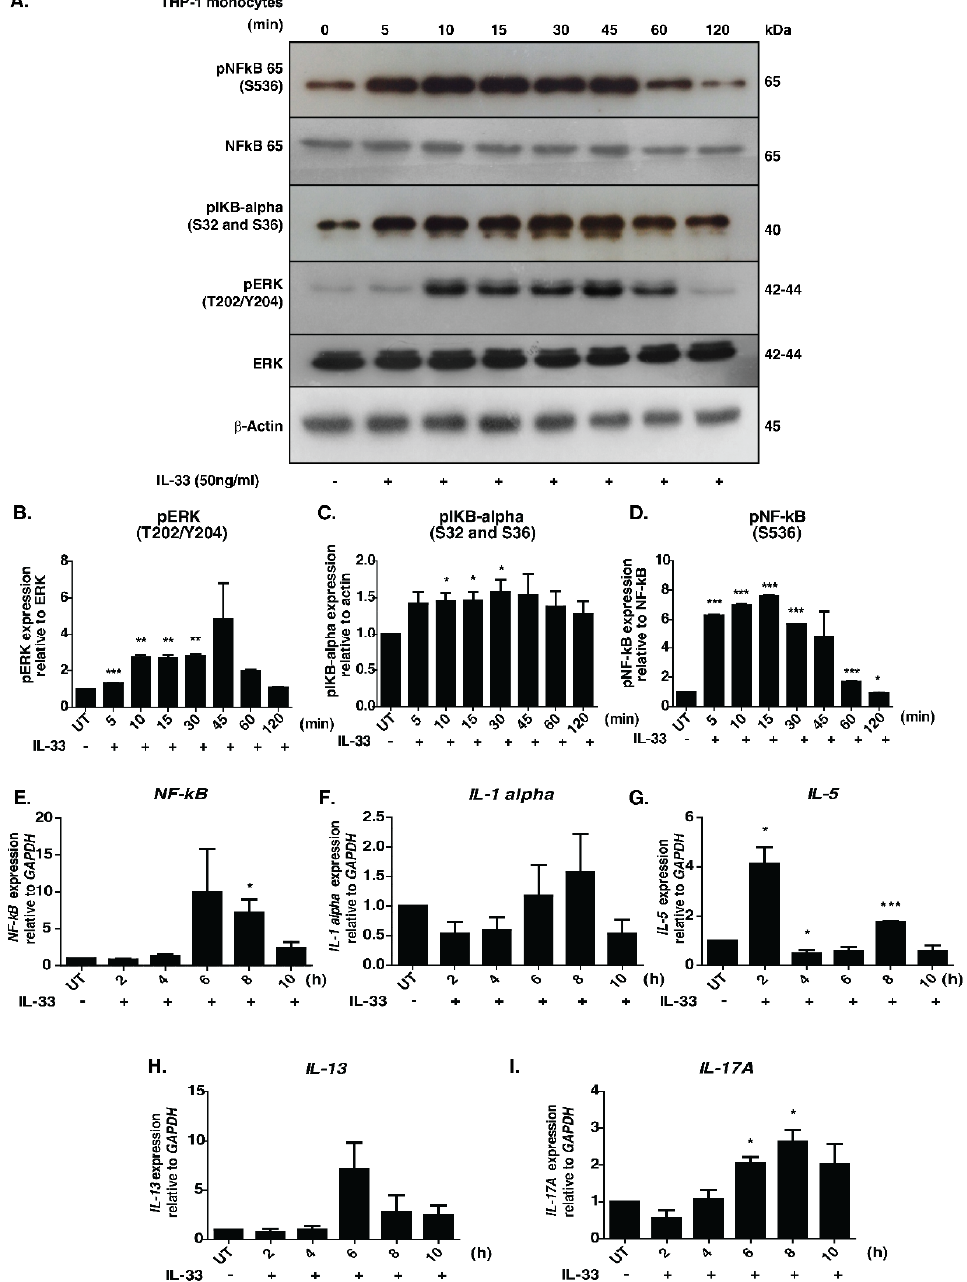
Figure 1. Effect of IL-33 treatment on the MAPK and NF κ B signaling cascades in THP-1 monocytes. ( A ). Western blot analysis showing the effect of IL-33 (50 ng/mL) on the phosphorylation status of NF-kB-p65 (S536), IKB α (S32/36), total NFKB p65, total ERK1/2 and phosphorylated ERK1/2 (T202/Y204) at different time points (5, 10, 15, 30, 45, 60, and 120 min). Densitometry analysis of the Western blots for ( B ) ERK1/2, phosphorylated ERK 1/2, ( C ) phosphorylated I κ B α , ( D ) NF κ B-p65 and phosphorylated NF κ B-p65. The relative fold changes are shown. * p < 0.05 compared to control (Mean ± SEM, n = 3). Further, IL-33 treatment induced mRNA expression of various cytokines, including ( E ) NF-kB , ( F ) IL-1alpha , ( G ) IL-5 , ( H ) IL-13 and ( I ) IL-17A . Quantitative real-time PCR was carried out after stimulating THP-1 monocytes with IL-33(50 ng/mL for varying durations (2, 4, 6, 8 and 10 h). The results are shown as fold change with respect to control cells (0 min). All the experiments were repeated in triplicates. * p < 0.05 compared to control (Mean ± SEM, n = 3). ** and *** denote medium and highly significant values